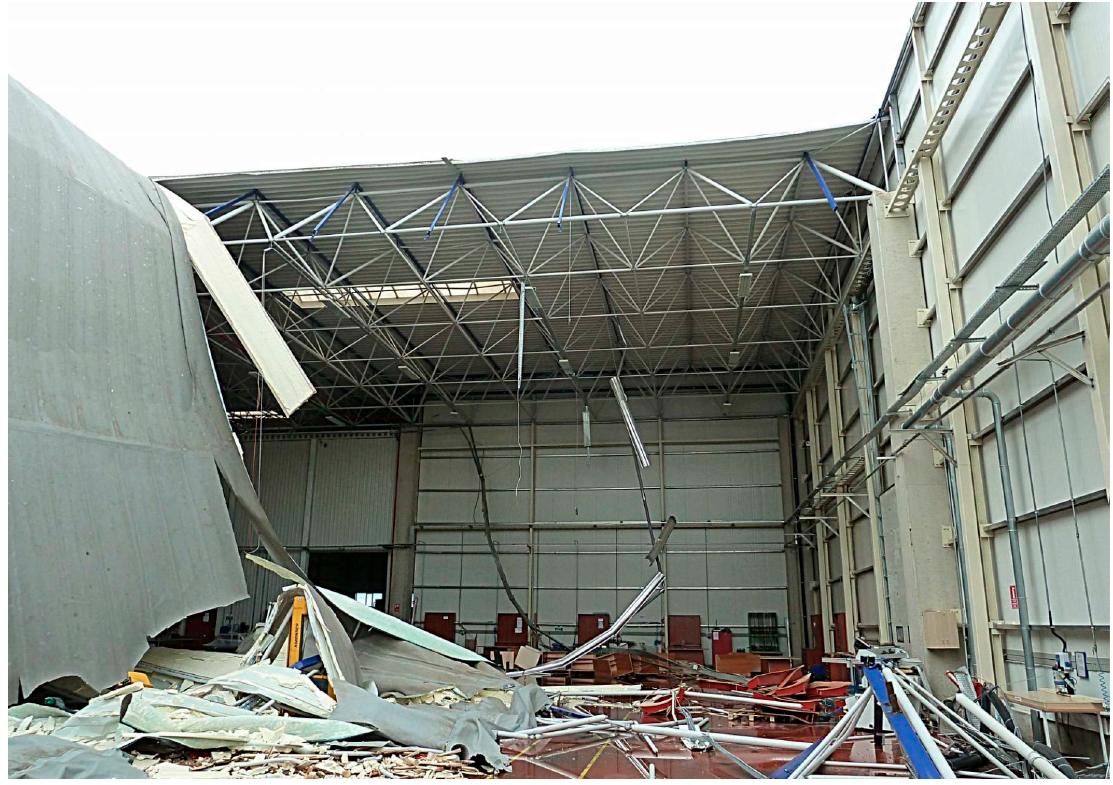
Figure 4. Damage to the roof’s space truss system.